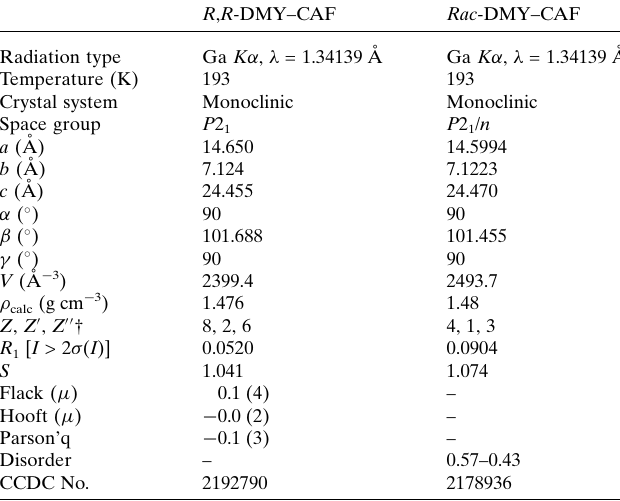
Table 1 Crystallographic data of DMY–CAF crystal